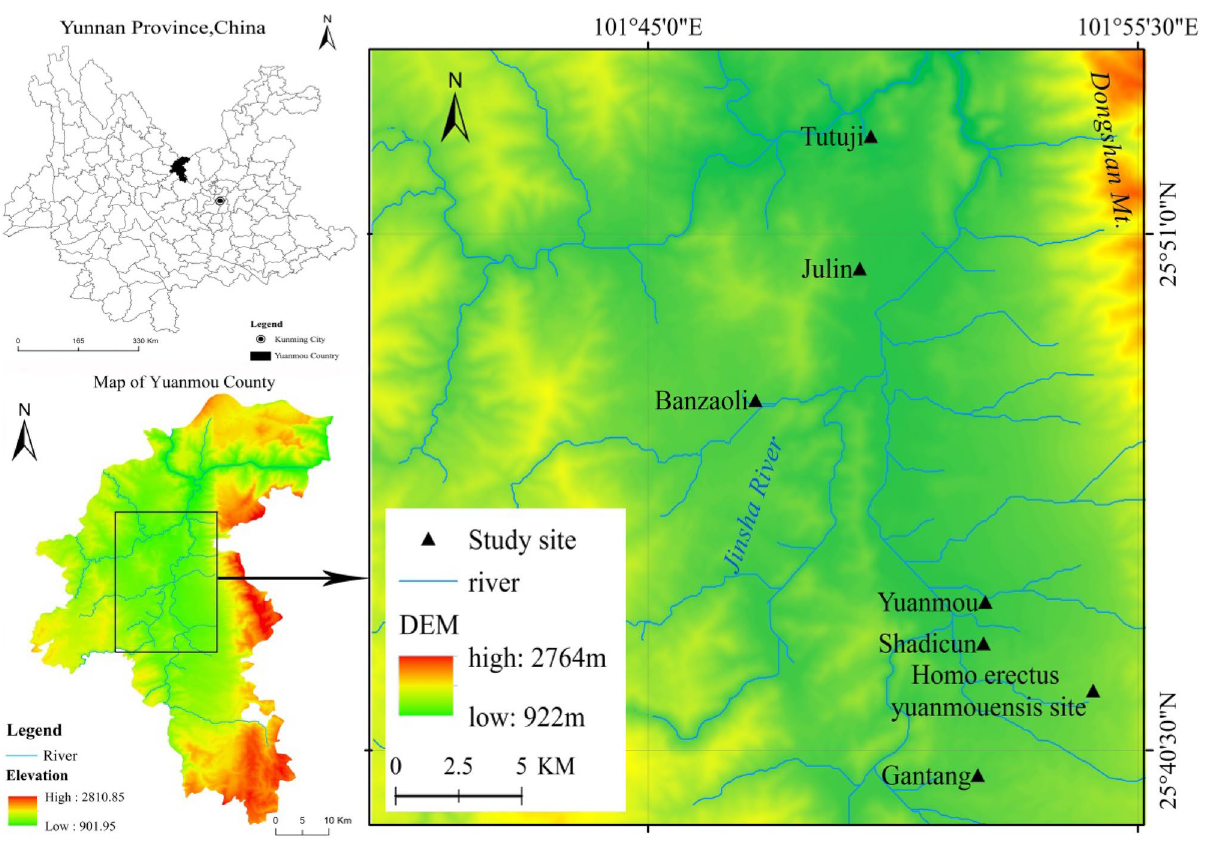
Figure 6. Location of the study area. Note: This map was created using ArcGIS Desktop 10.8.1 (ArcMap) software: https:// www. esri. com/ en- us/ arcgis/ produ cts/ arcgis- deskt op/ overv